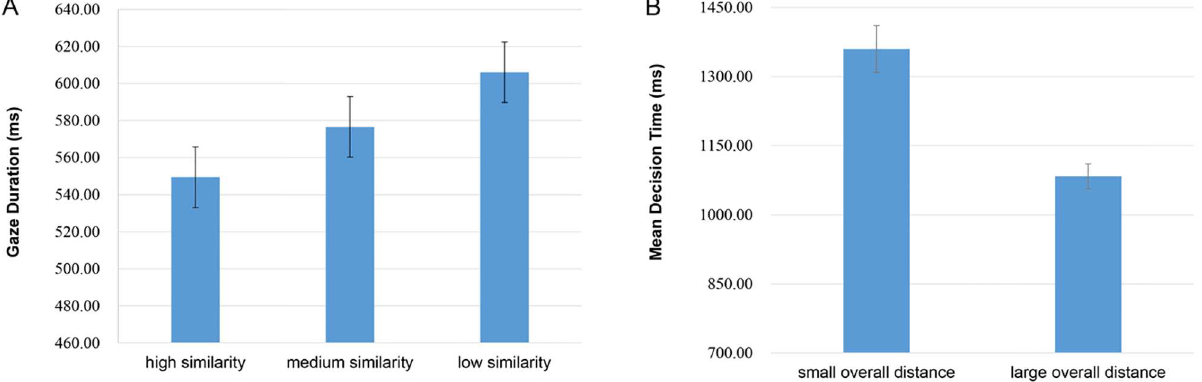
Fig 2. Gaze duration times and mean decision times result in Experiment 1. (A) Gaze durationtimes of middle word for trials with high, medium and low similarity in semantic shape between the first word and middle word, the result showed a distance priming effect. (B) Mean decisiontimes for trials with small and large overall distance, the result showed a symbolic distance effect. Error bars indicate 95% confidenceintervals.